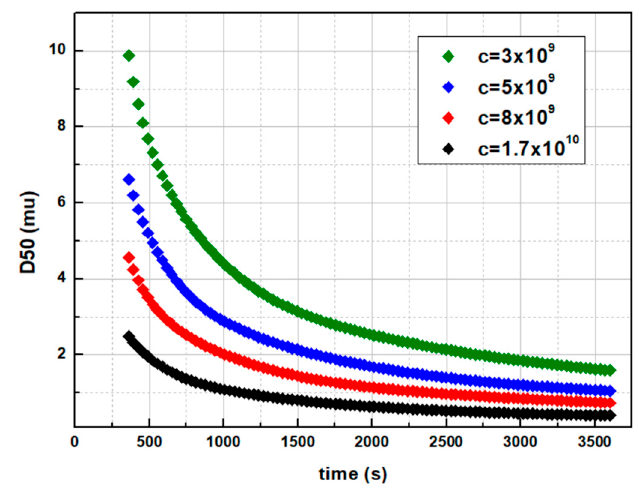
Figure 5. Breakage parameter c effect on the size comminution profile.